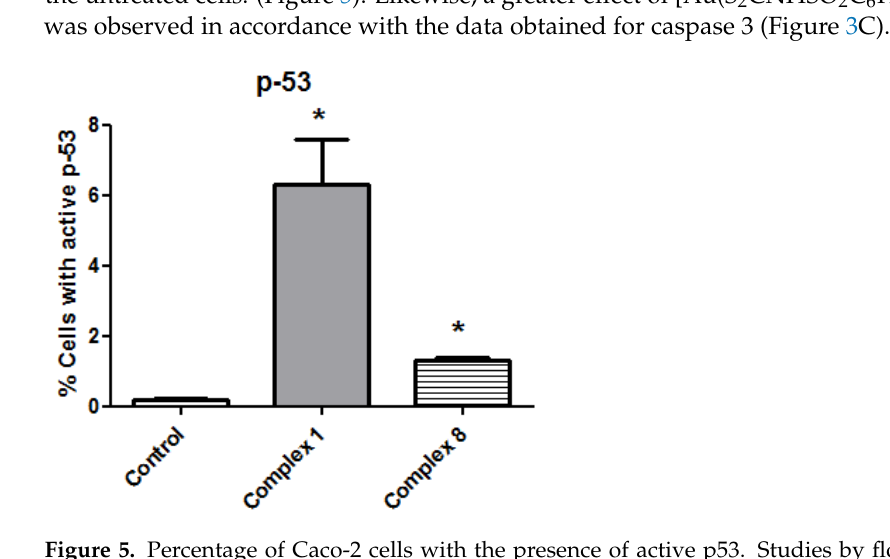
Figure 5. Percentage of Caco-2 cells with the presence of active p53. Studies by flow cytometry after after incubation with complexes 1 (1.14 µ M) and 8 (7.22 µ M) for 48 and 72 h, respectively. * p < 0.05